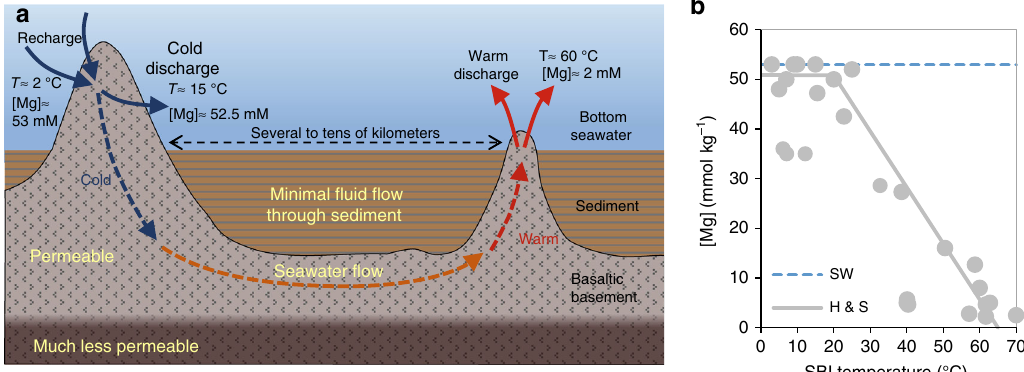
Fig. 2 The low-temperature hydrothermal (LTH) system. a Schematic illustration of ridge- fl ank hydrothermal circulation and its effect on temperature, T, and Mg concentration, [Mg] (after Fisher and Wheat 29 ). The sediment cover has low permeability relative to the basalt that comprises the upper permeable portion of the basaltic basement 35 . b Concentration of Mg vs. temperature at the sediment-basement-interface (SBI) in LTH fl uids (data from Wheat et al. 34,36,37,39 , Fisher et al. 38 , and Fisher and Wheat 29 and references therein). Blue-dashed line (SW) is seawater Mg concentration (~53 mmol kg − 1 ). Gray-solid line (H&S) is a modeled temperature dependence taken from Higgins and Schrag